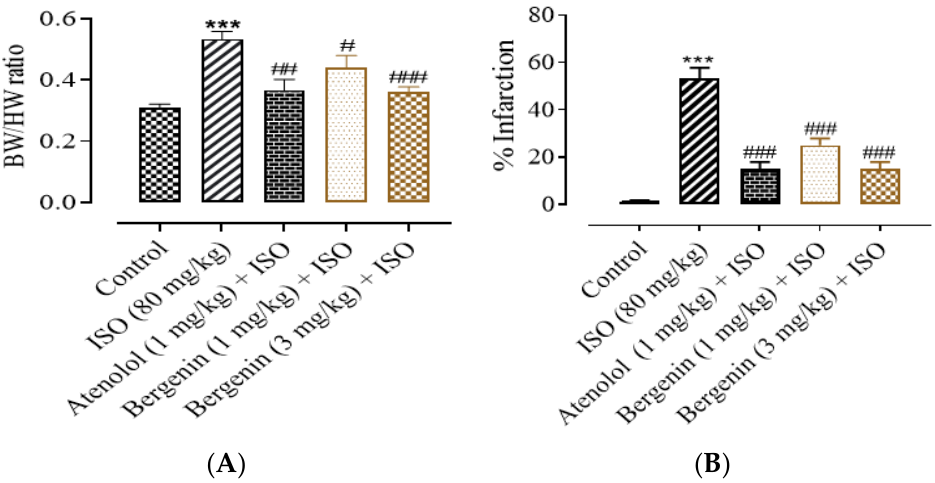
Figure 3. ( A ) Shows the effect of bergenin + ISO, atenolol + ISO and ISO on body weight/heart weight (BW/HW) ratio in comparison to control. The graph ( B ) shows the percent myocardial infarct size in the control and treated groups. All values represent the mean ± SEM of six determinations, where #, ##, ### indicates < 0.01 and 0.001 p values vs. ISO, respectively, and *** describes p value < 0.001 vs. Control.